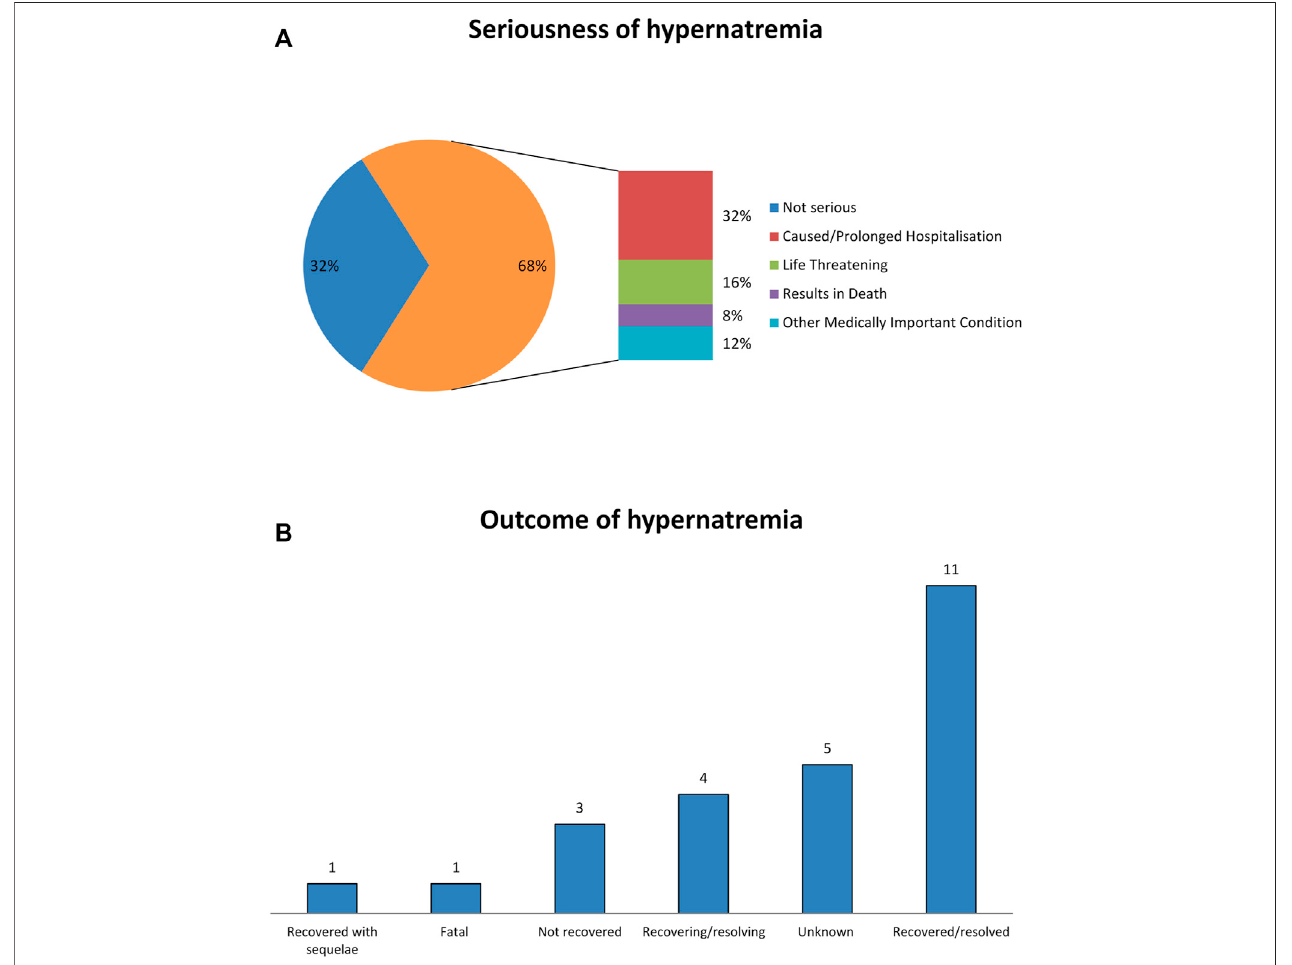
FIGURE 1 | Seriousness criteria and outcomes of fosfomycin-induced hypernatremia from EudraVigilance data. (A) Seriousness of hypernatremia. (B) Outcomes of hypernatremia.